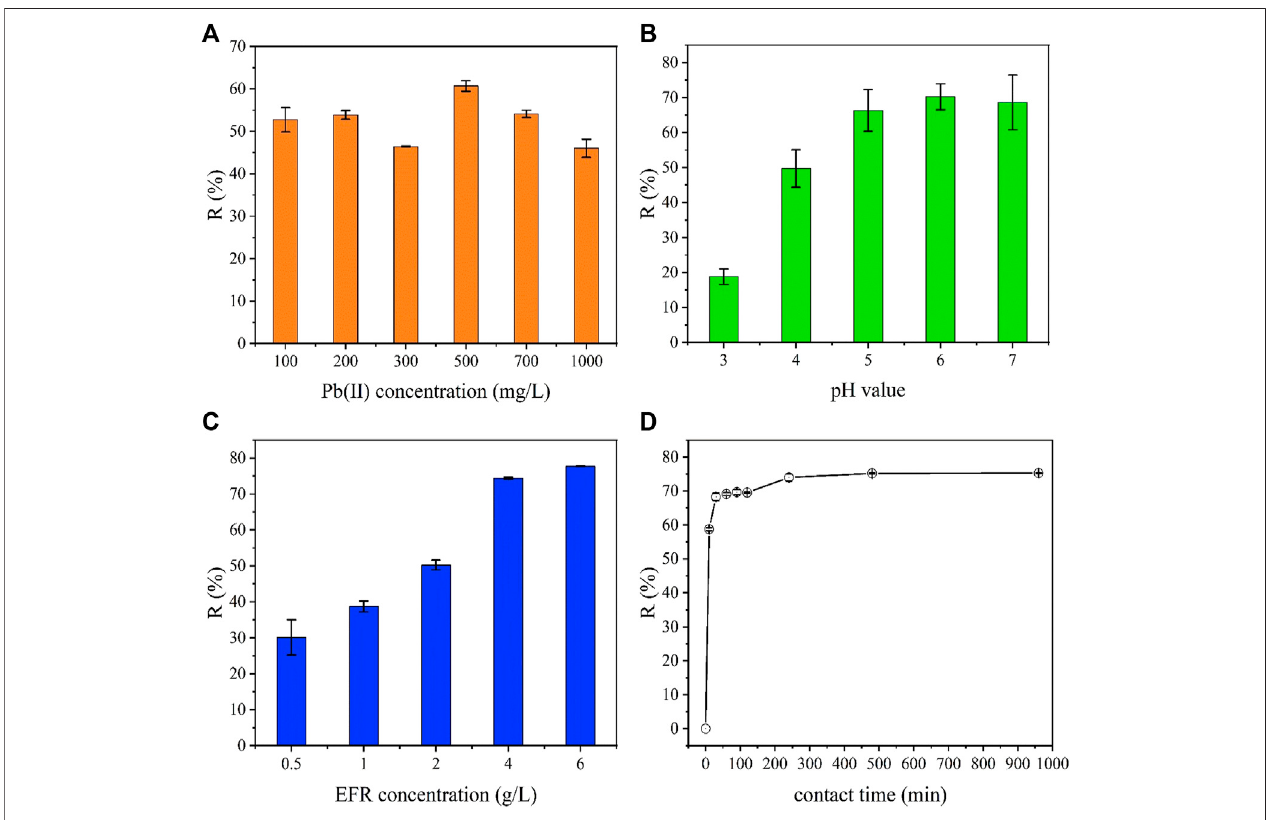
FIGURE 2 | R of Pb(II) at different Pb(II) concentration (A) , values of pH (B) , EFR concentration (C) , and contact time (D) .